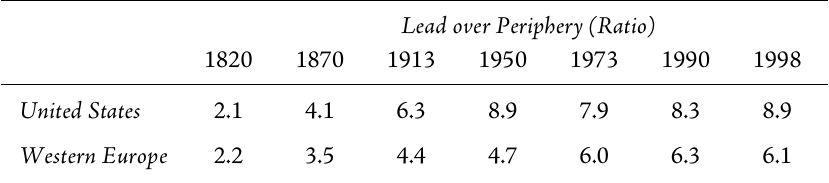
Table 1 – Global Disparities in PCI: Aggregate Views Lead over Periphery